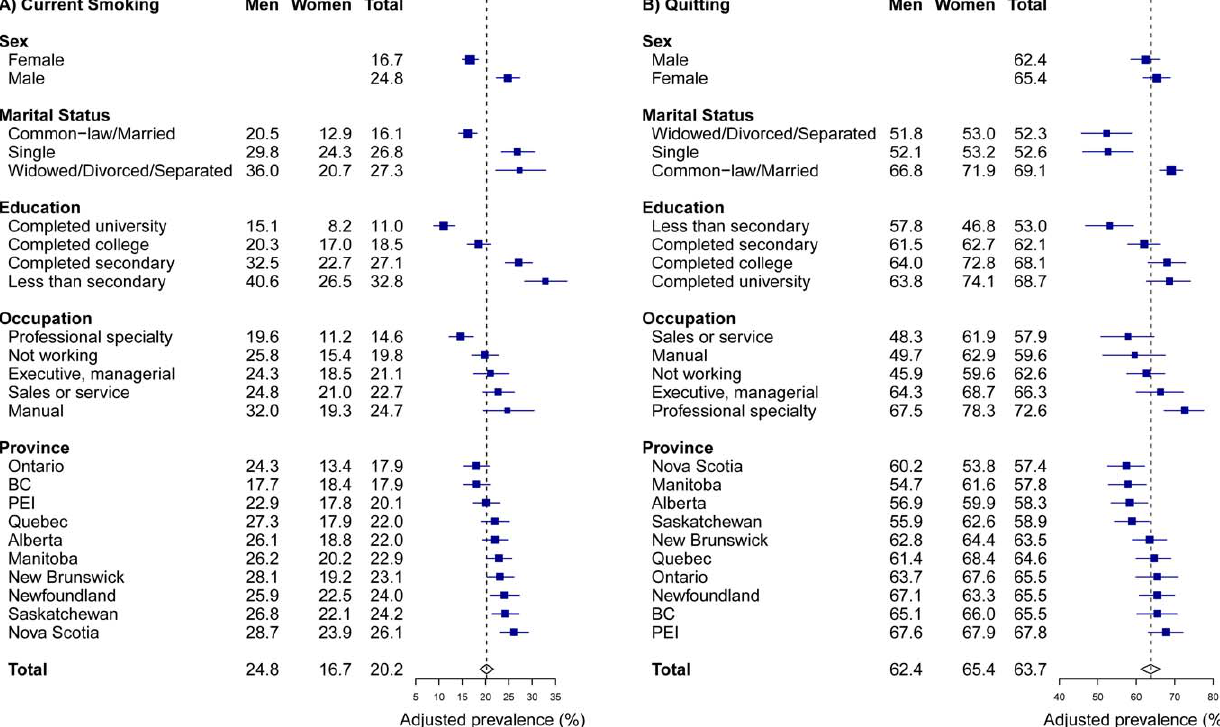
PLOS ONE | www.plosone.org